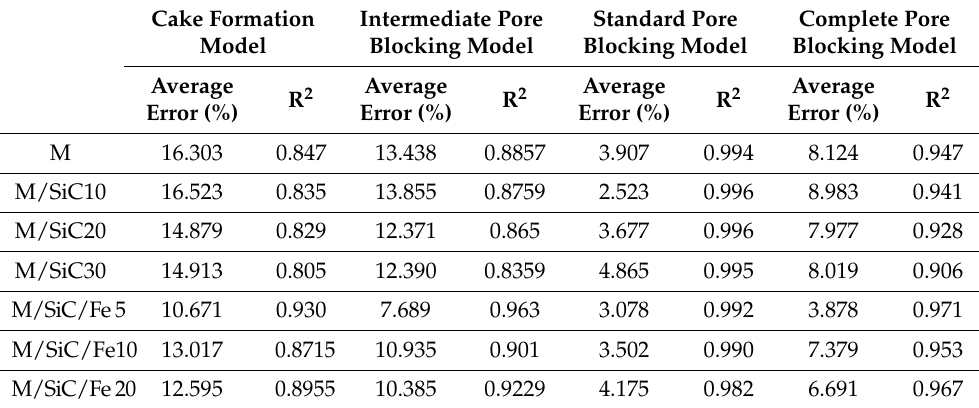
Table 7. The mean error between experimental fluxes and the modeled ones, using Hermia’s models for the manufactured microfiltration